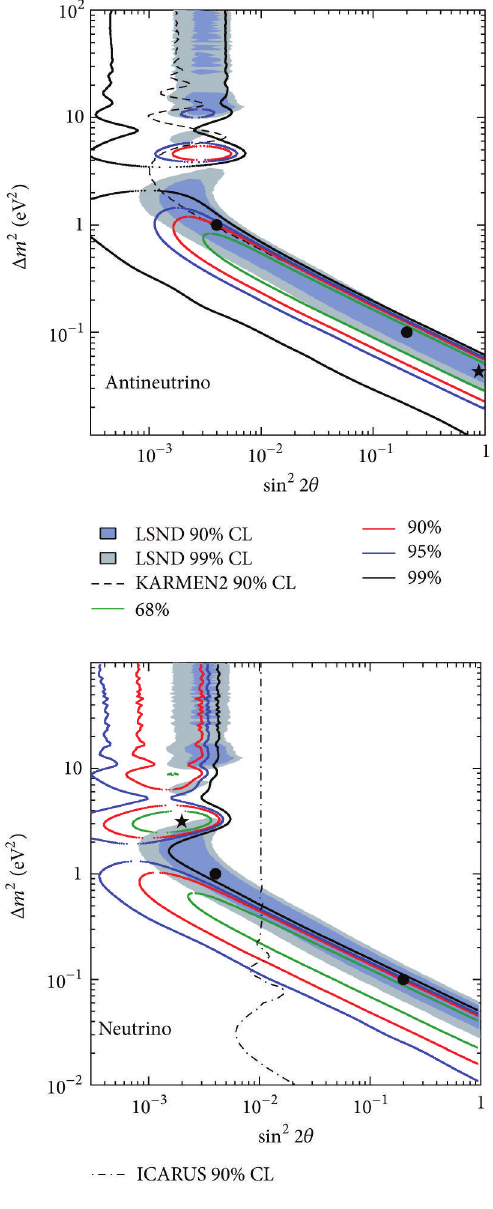
Figure 12: The allowed regions for ] 𝜇 → ] 𝑒 and ] 𝜇 → ] 𝑒 from the MiniBooNE data [23] are shown. In the case of antineutrinos, they arecomparedwiththeLSNDallowedregionandwiththeKARMEN exclusion plot (to the right of the dashed